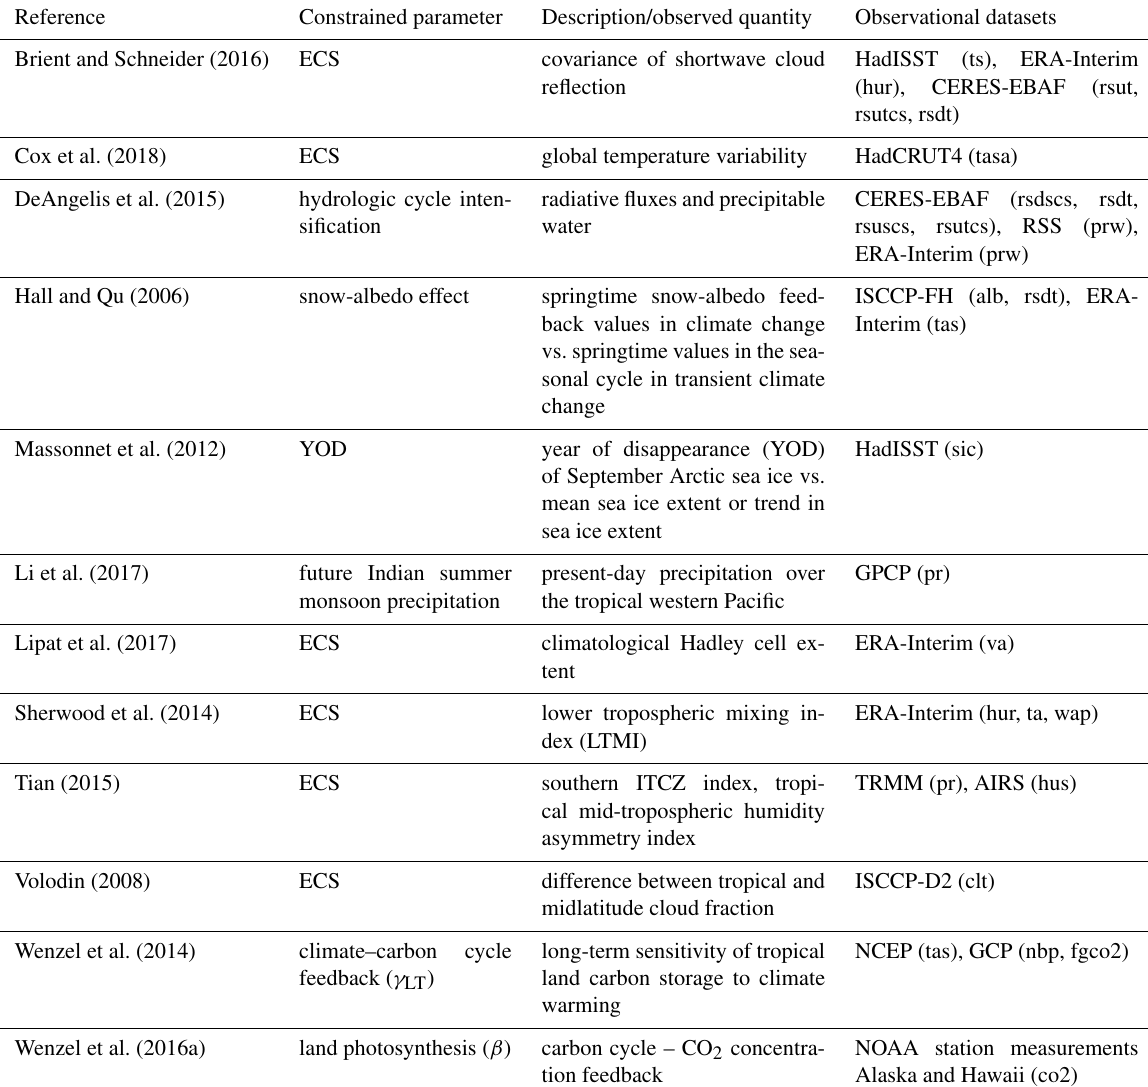
Table 2. Emergent constraints implemented in ESMValTool v2.0 and observational datasets